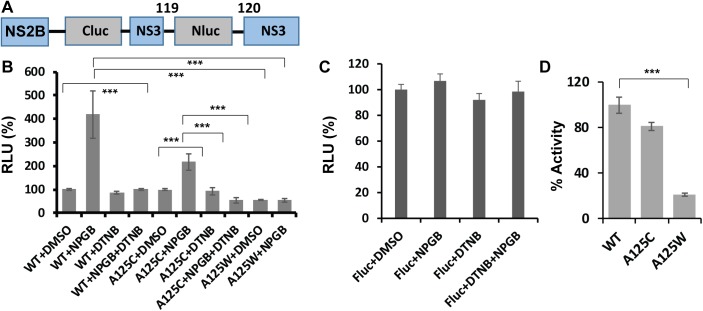
The SLC assays for conformational change of NS2B of DENV2.(A) Design of SLC construct for monitoring the NS2B conformational change (based on DENV2). (B) Active-site inhibitor NPGB triggers the SLC enhancement that can be suppressed by mutations at an allosteric site A125 of NS3. All proteins were at 150 nM. DTNB and NPGB were at 30 μM. n = 3. ***, p<0.01. (C) NPGB and DTNB do not affect the luciferase activity of the full-length luciferase (FLuc) (150 nM). (D) Protease activity of the WT and mutant N2CN3N. All proteins (150 nM) were assayed with the Abz substrate (100 μM) for 1 hour. The activity of WT was set as 100%. The relative activities of the mutants were normalized as percentage of the WT activities.